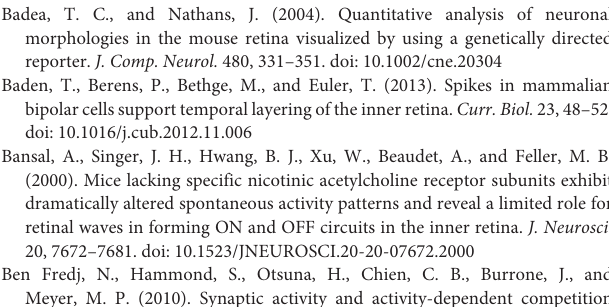
FIGURE S1 | The size of the dendritic field of J-RGCs increases with eccentricity. The dendritic field size of each J-RGC was quantified and correlated to the distance of the soma to the optic nerve head. (A) A representative image of a maximum projection of confocal image of a flat-mounted whole retina of a P60 JamB-CreER:Thy1-YFP mouse. The circles of white dotted line indicate distance of eccentricity of 500 µ m, 1000 µ m and 1500 µ m from the optic nerve head. (B) The scatter plot of the DF size of J-RGCs as a function of the distance of eccentricity of 80 J-RGCs (2 mice, 3 retinas). (C) The average DF size of J-RGCs grouped based on their eccentricity distance. ∗ P < 0.05; ∗∗ P < 0.01; and ∗∗∗ P <